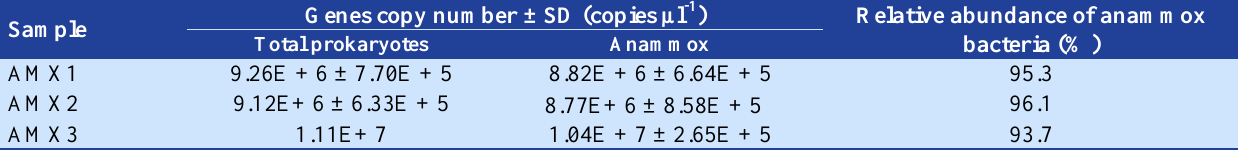
Table 3. Real-time quantitative polymerase chain reaction (RT-PCR) results for the water samples from anammox-reactor